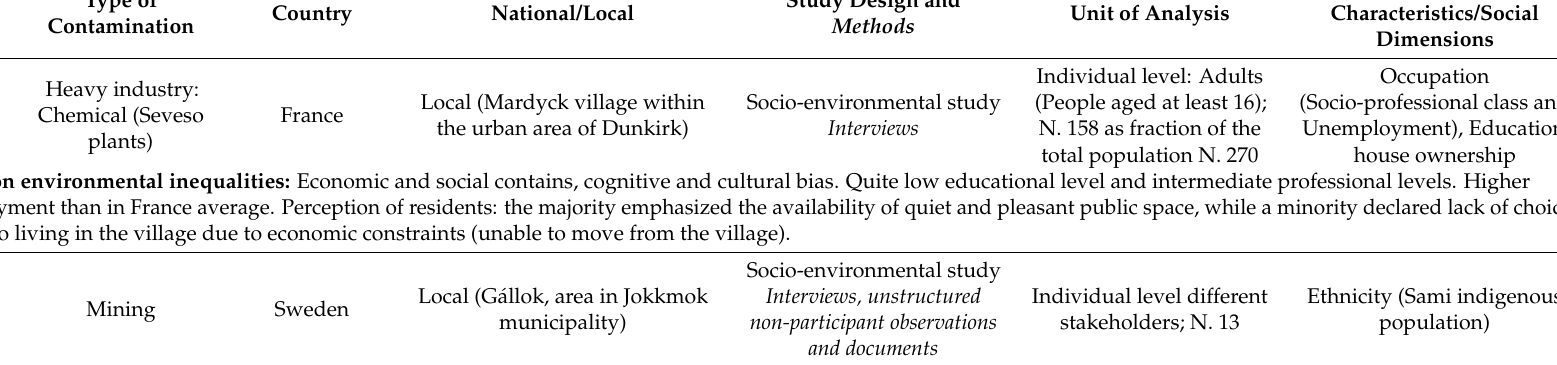
Table 3. Main characteristics and results of identified studies on distributive justice in industrially contaminated sites, 2010–2017.